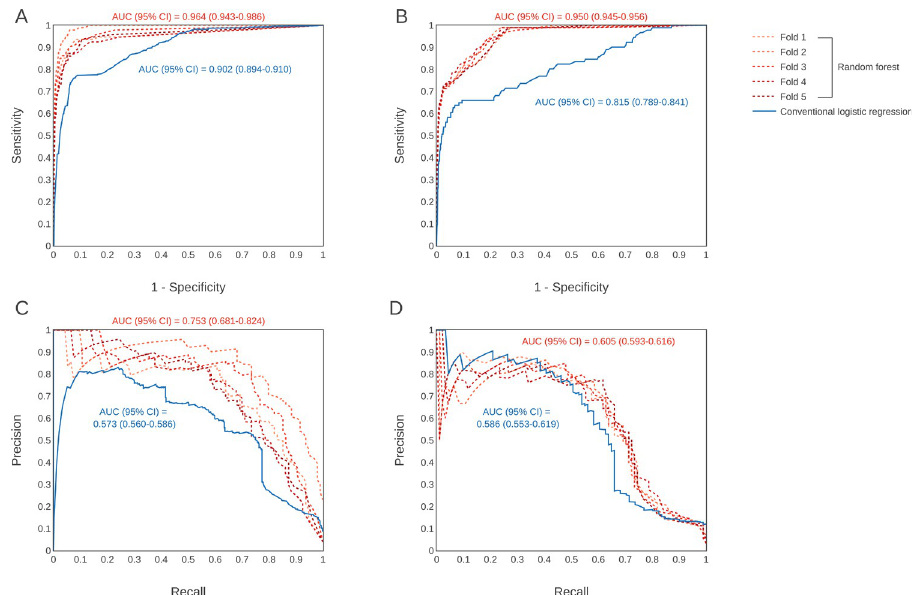
Fig 2. Internal and external validation of predictive models. The area under the receiver operating characteristics curves of the derivation cohort (A), the curves of the validation cohort (B), and the area under the precision-recall curves of the derivation cohort (C) and validation cohort (D) are shown. AUC = the area under the curve, CI = confidence interval.